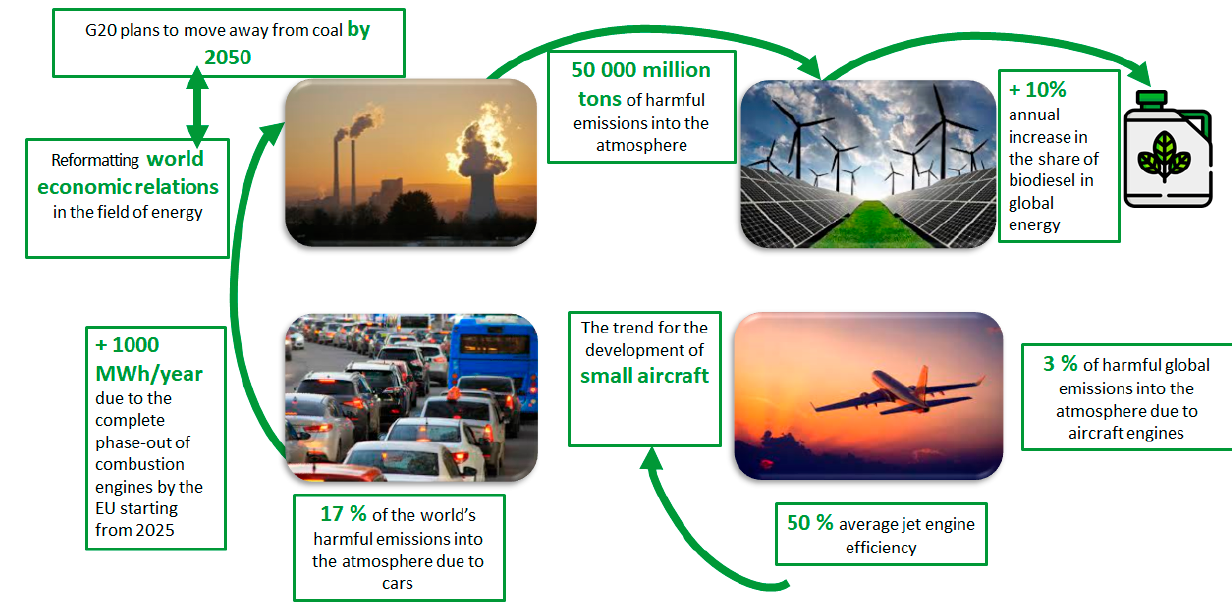
Figure 1. Modern challenges on the topic of advanced fuel formulations.